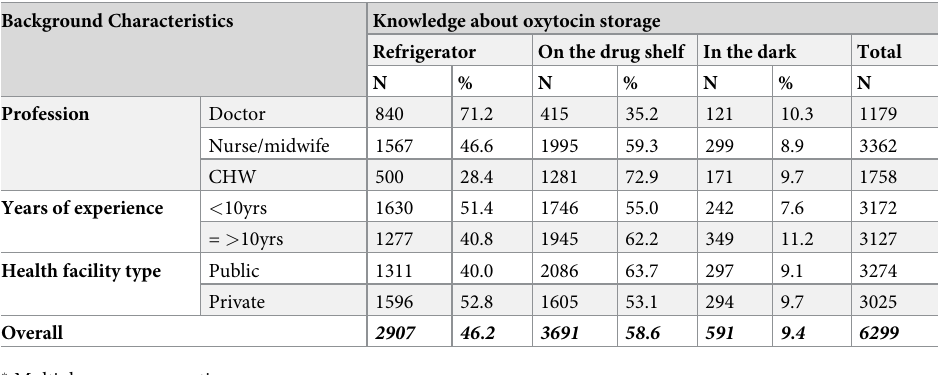
Table 3. Respondents’ � characteristics by their knowledge about storage of oxytocin.